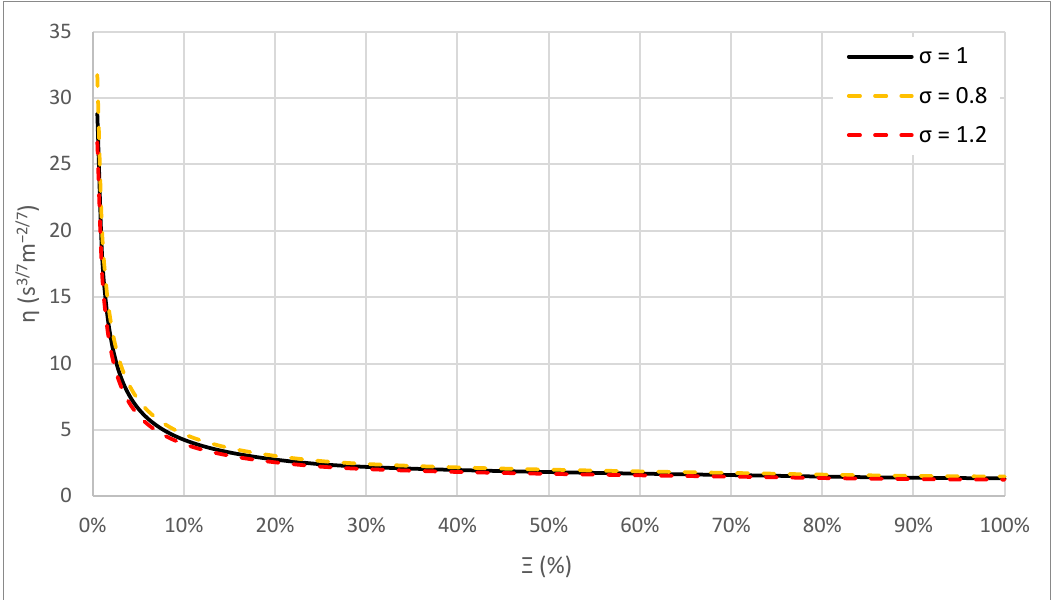
Figure 3. Comparison of Equation (14) results for 𝛿 = 0.5 and different 𝜎 values. As a general analytical method to estimate the Archimedes screw outer diameter based on the volumetric flow rate for all AST inlet depths, Equation (14) could be applied for δ = 0.5 , σ = 1 , θ = 3/7 and the corresponding η value of each dimensionless inlet depth.